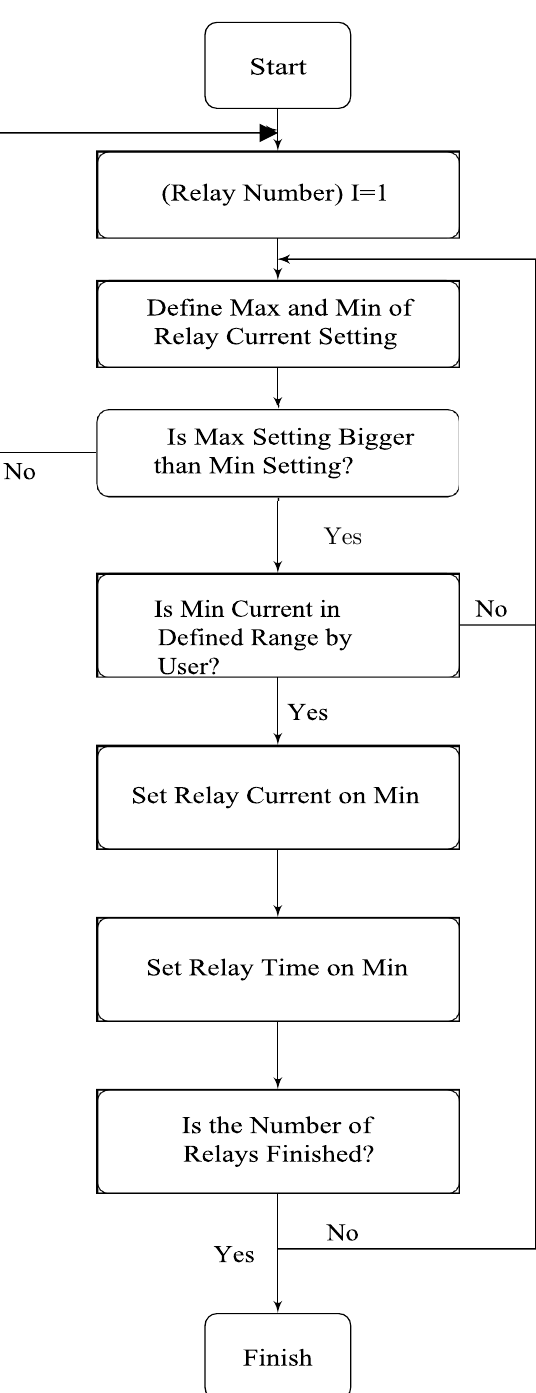
Figure 4. Current relay Fig. 5: Current Relay Coordination